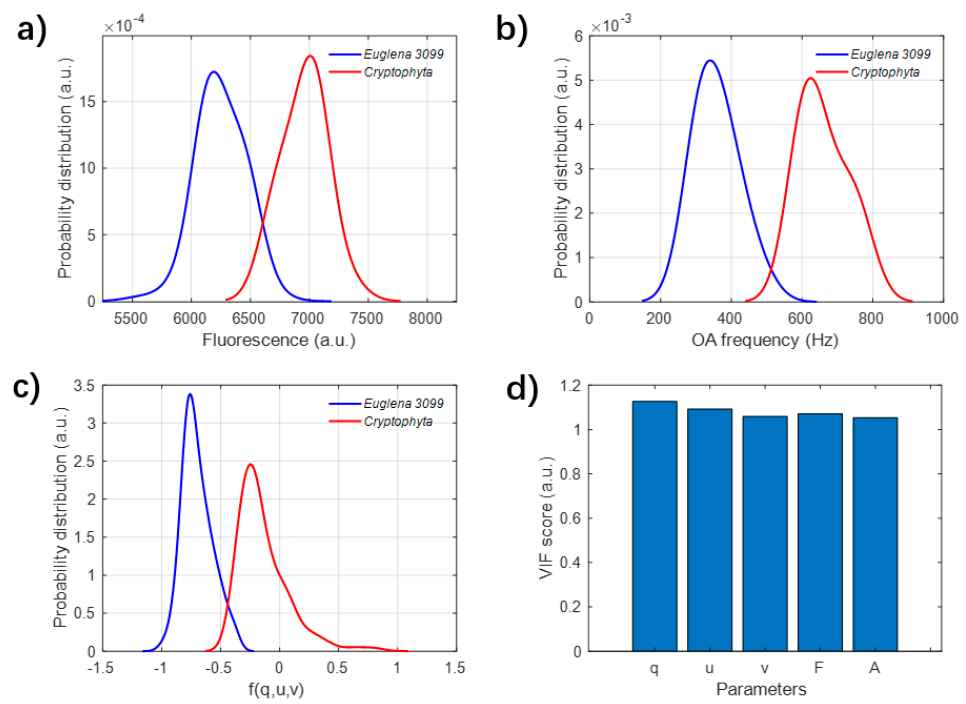
Figure 5. ( a – c ) The probability distributions of ( a ) acoustic frequency, ( b ) the fluorescence and ( c ) the projected polarization parameter f ( q , u , v ) of Euglena and Cryptophyta ; ( d ) the variance inflation factor (VIF) scores of these feature